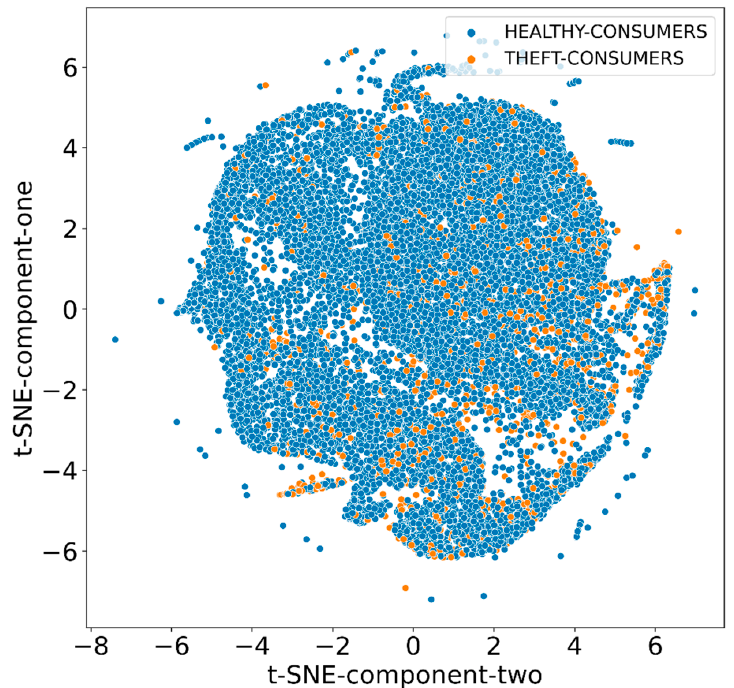
Figure 7. Data class distribution before using MWMOTE algorithm (imbalanced dataset).